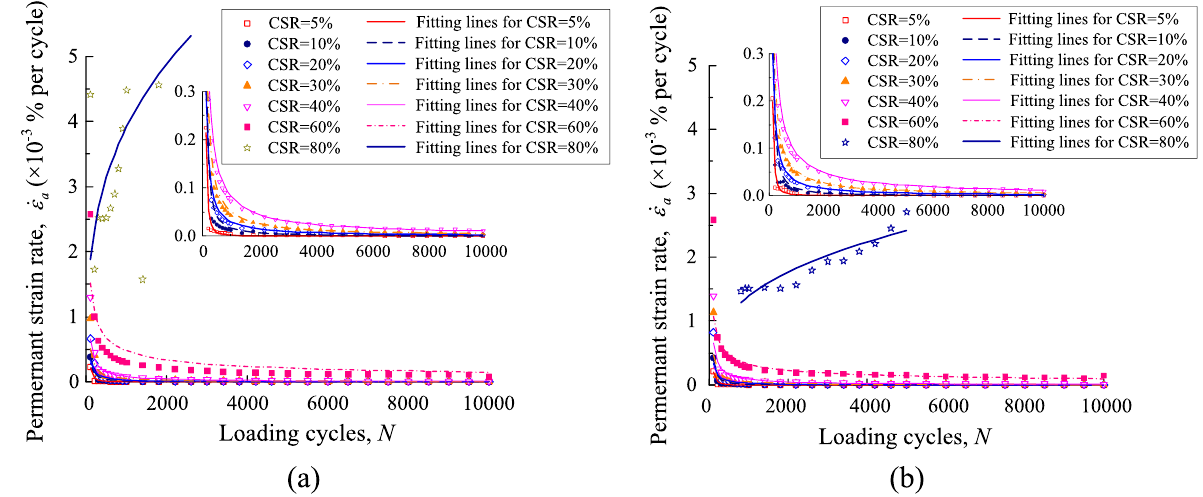
Figure 8. Permanent strain rate against loading cycles for gravel samples with DoC = 0.95 at the confining pressure of ( a ) 40 kPa and ( b ) 60 kPa.